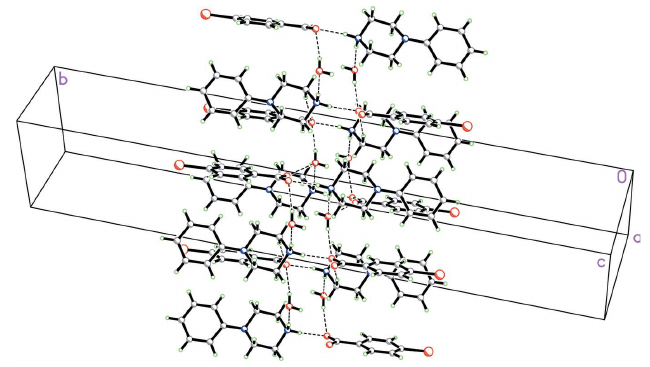
Figure 13 Packing diagram for 3 viewed along the [101] direction showing both R 4 (12) rings demonstrating N—H (cid:2)(cid:2)(cid:2) O and O—H (cid:2)(cid:2)(cid:2) O hydrogen bonds (12) rings 4 6 involving the cations, anions and water molecule as well as R 2 showing O—H (cid:2)(cid:2)(cid:2) O hydrogen bonds just associated with the cations and anions. These link the cations, anions and water molecules into ribbons propagating in the [101] direction.